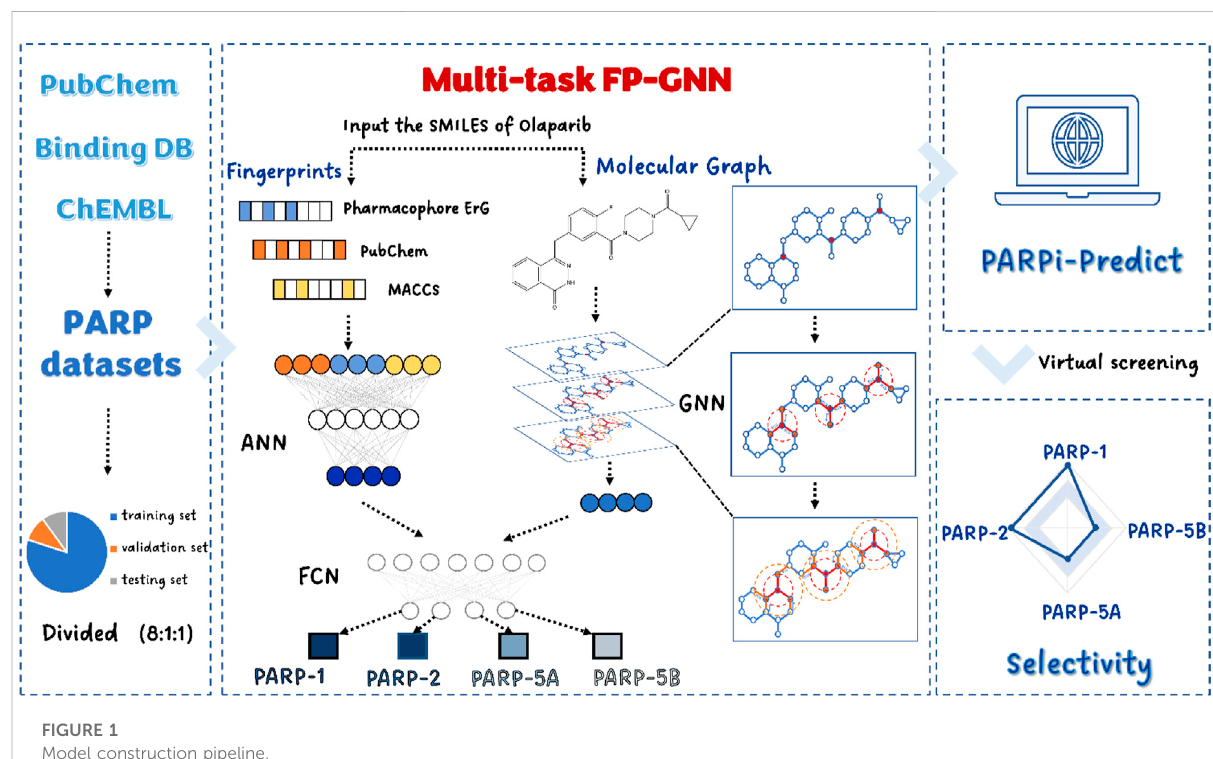
FIGURE 1 Model construction